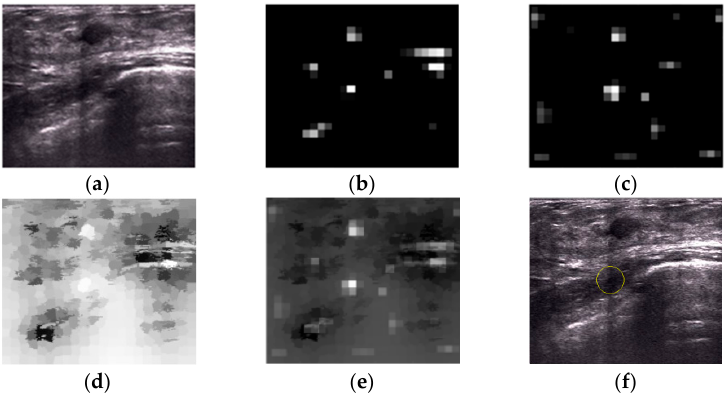
Figure 18. Wrong localization results of Liu’s method and the proposed method. ( a ) Localization results of Liu’s method and ( b ) the results of the proposed method.